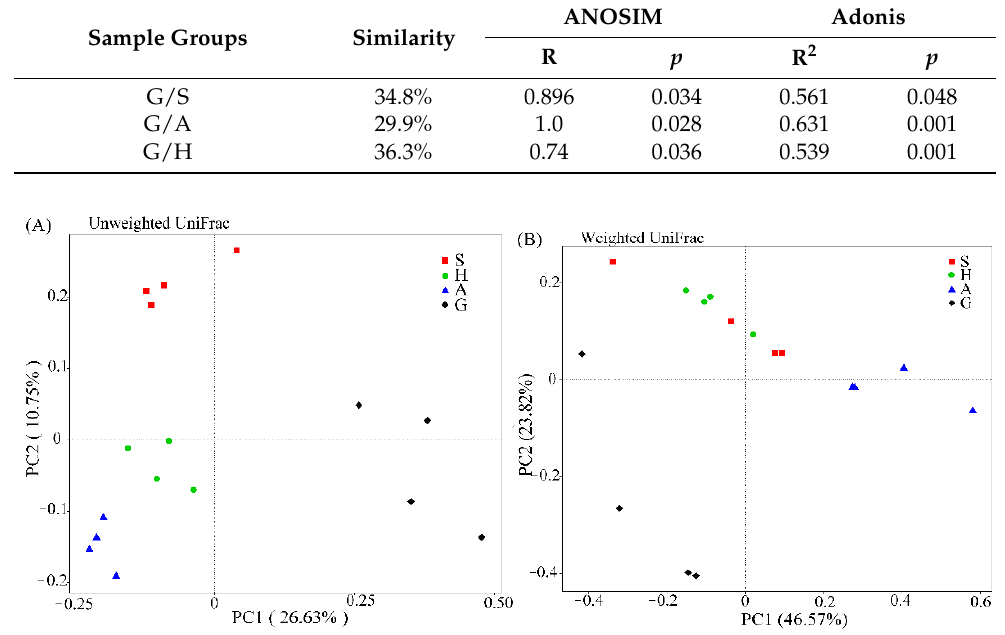
Figure 2. Principal coordinate analysis (PCoA) plots of ( A ) unweighted and ( B ) weighted UniFrac distances between microbial communities in the worm intestine and different sediments from a Sipunculus nudus aquaculture area. S—surface sediment; H—sediment in the hole; A—ambient sediment; G—gut of S. nudus